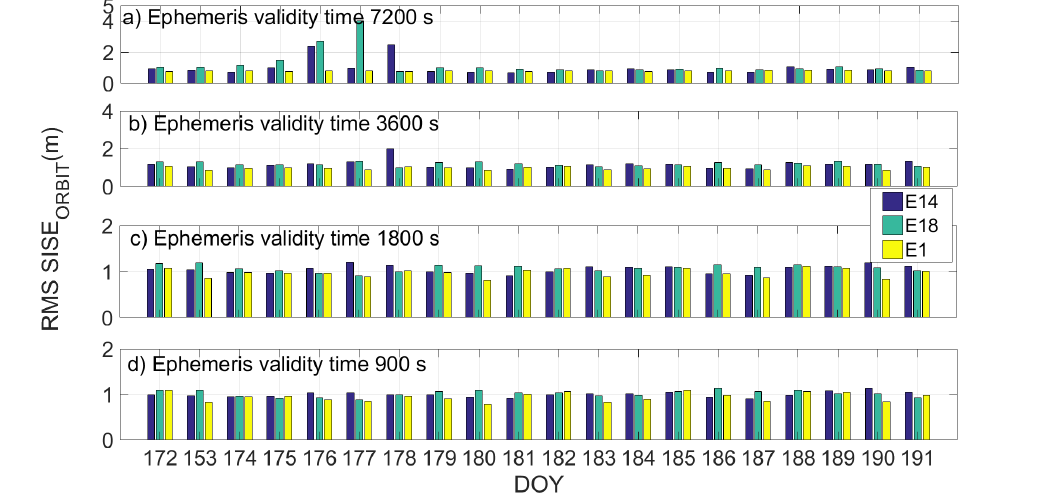
Figure 11. Daily RMS SISE orbit for satellite Milena (E14) and Doresa (E18) and satellite 1 (E1) represented by blue, green and yellow bars, respectively. SISE orbit was calculated by using a validity time of 7200 s, 3600 s, 1800 s and 900 s in ( a – d ), respectively. Figure refers to DOYs